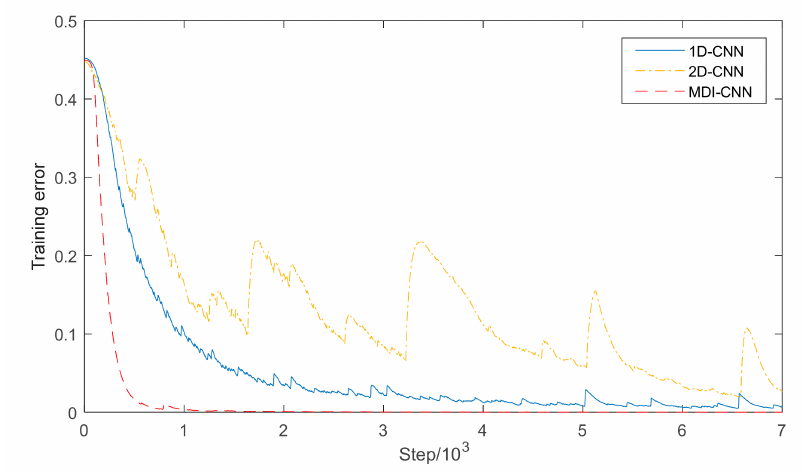
Figure 5. The training